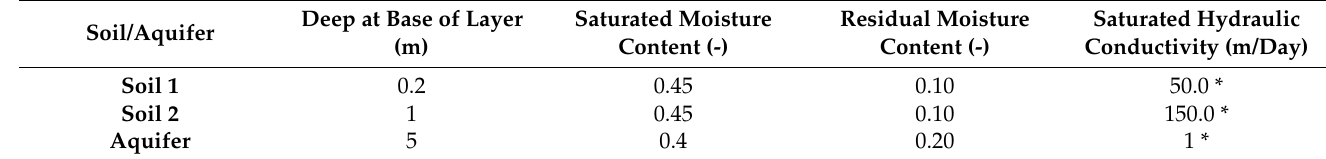
Table 1. Soil and aquifer parameters used in the model. * indicates a parameter was calibrated.